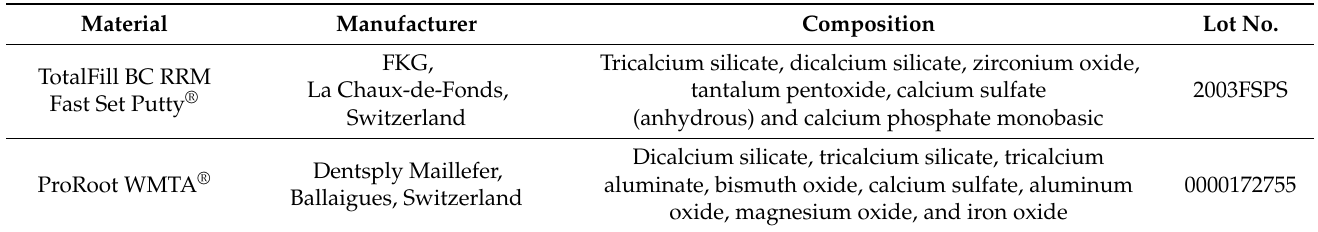
Table 1. Manufacturer, composition, and lot no. of the endodontic cements used.